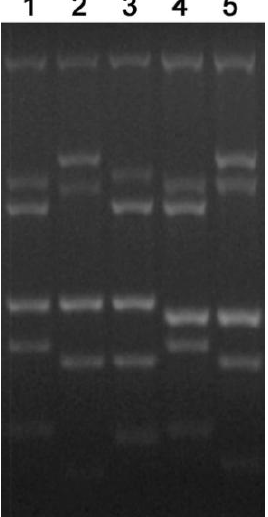
Figure 3. Multiplex PCR of Neospora caninum DNA was performed with a PCR for the six markers Tand-3, Tand-12, Tand-13, Cont-6, Cont-14 and Cont-16. Lanes 1, BPA6; 2, NC-Beef; 3, JAP1; 4, WA-K9, 5, NC-Bahia. The sizes of the PCR products (bp) for NC-Bahia [129] are Tand-3, 140; Tand-12, 277; Tand-13, 340; Cont-6, 681; Cont-14, 619; Cont-16,